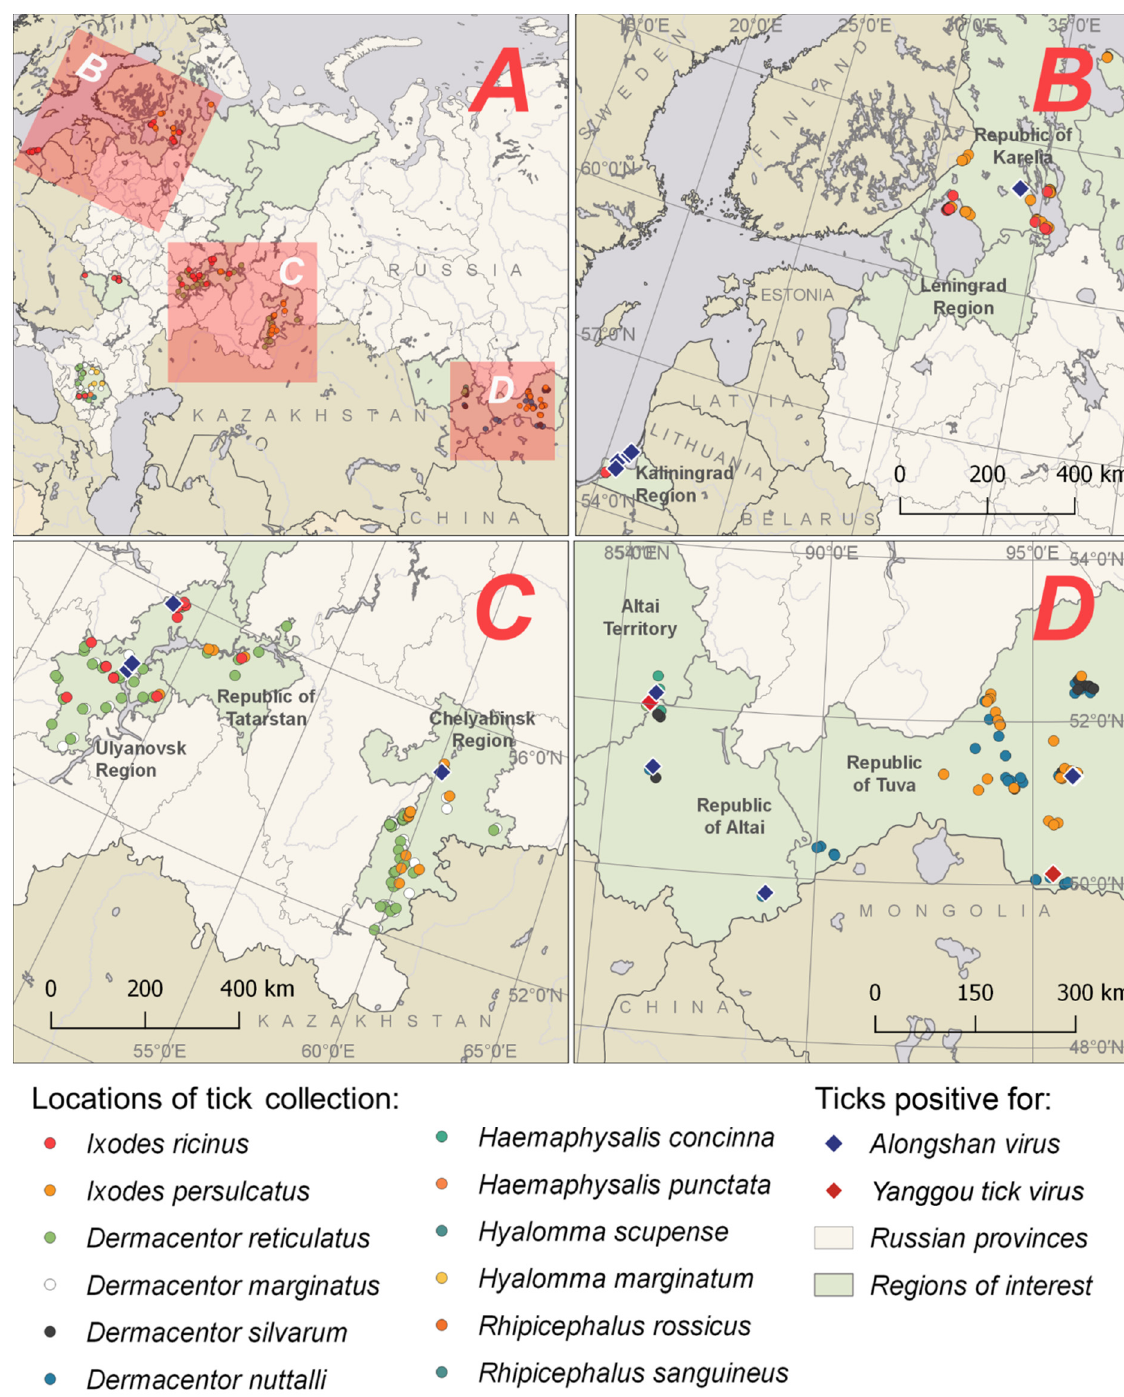
Figure 2. Locations of the Alongshan virus and Yanggou tick virus detection in ticks collected from vegetation and animal hosts in different regions of Russia. ( A ) Location of sample areas shown in detail in maps B, C and D; ( B – D ) Locations where ticks were collected.